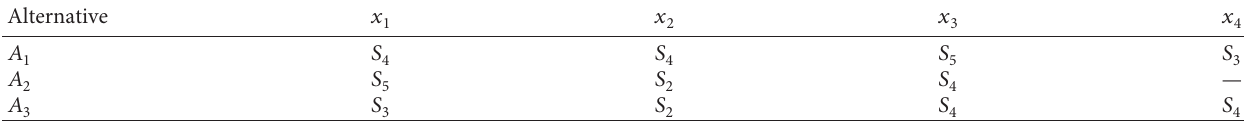
Table 24: The linguistic decision matrix provided by the fourth DM.